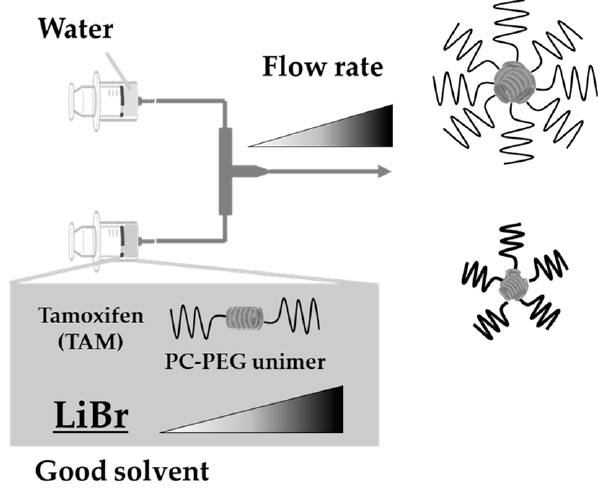
Figure 1. The schematic representation of the nanoparticle preparation.